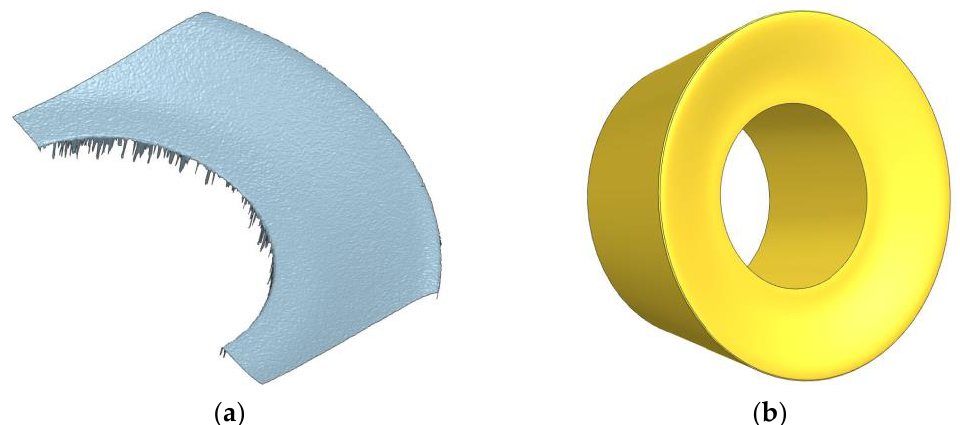
Figure 2. Reconstruction of cutting edge geometry: ( a ) cutting insert scan; ( b ) cutting insert model.